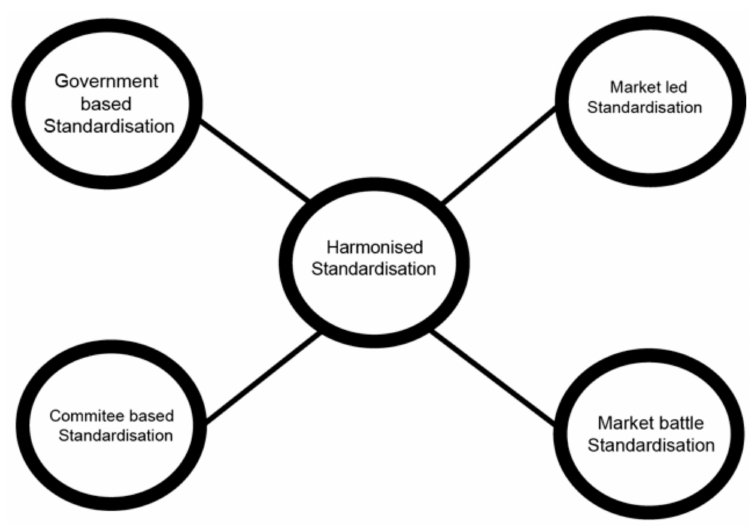
Figure 4. Multi-model standardisation approaches in an EV